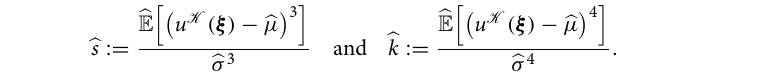
E [ ( u E ( u ))( v E ( v )) ] is the covariance between u and v . The square of Pearson’s coeffi- where C ov ( u , v ) := − − r ( u , v ) 2 0, 1 cient is the coefficient of determination R 2 ( u , v ) , which represents the percentage of variation := ∈ [ ] of u due to a linear variation of v . Empirical estimates of r ( u , v ) and R 2 ( u , v ) are plotted on Fig. 3 in which the lower (resp. upper) parts of the matrices correspond to the small (resp. large) range case. Three pairs presented a particularly strong correlation ) were negatively correlated pH ) and ( pH, log p CO regardless of the parametric domain size: the pairs ( pH, pe 10 2 + ) was positively correlated with 88% and R 2 97% respectively, whereas the pair ( pe pH, log p CO with R 2 10 2 = = + ) pair correlation can be understood by noting that the standard deviation of Ca 2 + R 2 80% . The ( pH, log p CO 10 2 = concentration (Table 2) was small compared to its mean value (Table 1) and that the log 10 p CO value is directly 2 pH ) cannot be explained related to pH by the Calcite equilibrium reaction. The correlation in the pair ( pH, pe + by the known negative correlation of the pair ( pe, pH ) at constant dioxygen or dihydrogen fugacity through pH diagram representation: the QoI 1 slope in the pe corresponding Nernst’s equation, which results in a − − pH was indeed meant to suppress this correlation. Consequently, the observed transformation from pe to pe + negative correlation must be attributed to particular equilibrium reactions. Goethite equilibrium, the reaction pH diagram, may explain the observed correlation. 3 slope in a pe of which results in a − −